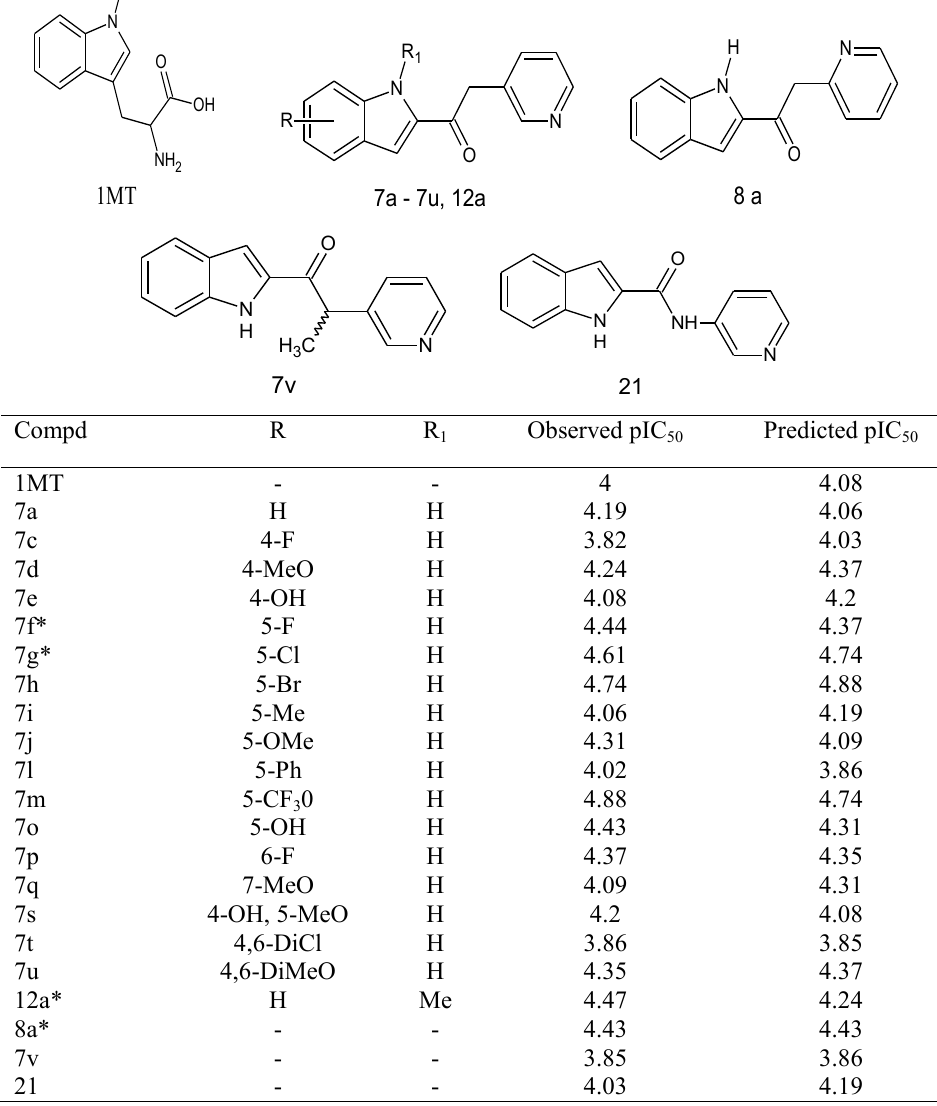
Table 1. Structure of training and test sets of compounds along with observed and predicted